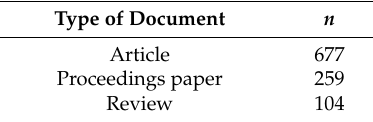
Table 4. Types of